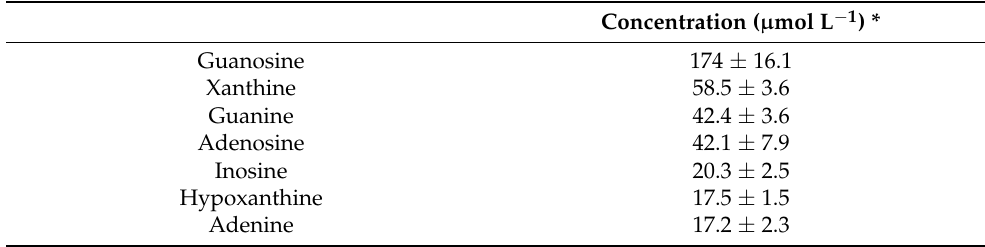
Table 2. Content of the most commonly found purine compounds in beer